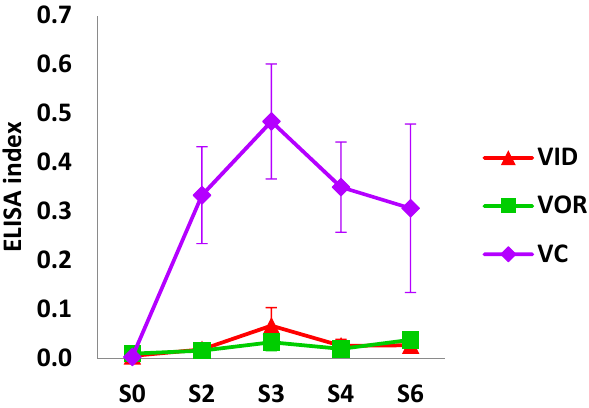
Figure 2. ELISA index time course of the vaccinated animal groups.